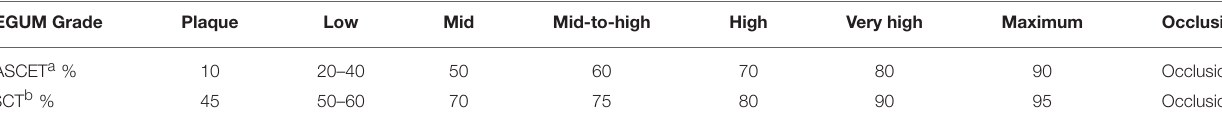
FIGURE 3 | Intraluminal mass. The persistent thrombus (arrow) originating from the vessel entry site of the former catheter, forming a intraluminal polypous mass. TABLE 1 | Classification of internal carotid artery